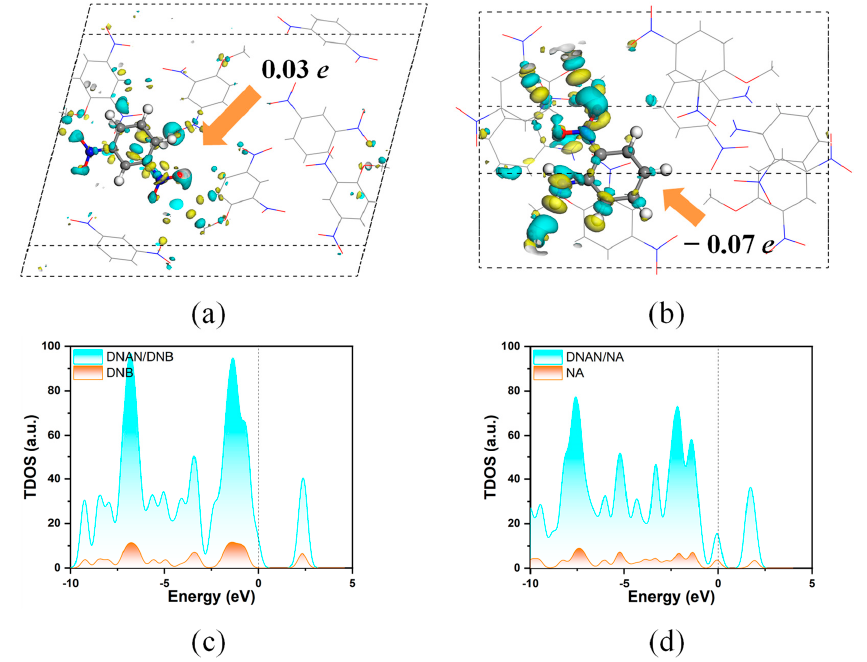
Figure 6. EDD ( Top row) and TDOS ( bottom row) in the two cocrystals: DNAN/DNB ( a , c ) and DNAN/NA ( b , d ). Blue and yellow represent the increase and decrease in the electron density, respectively (the isovalue is 0.01).